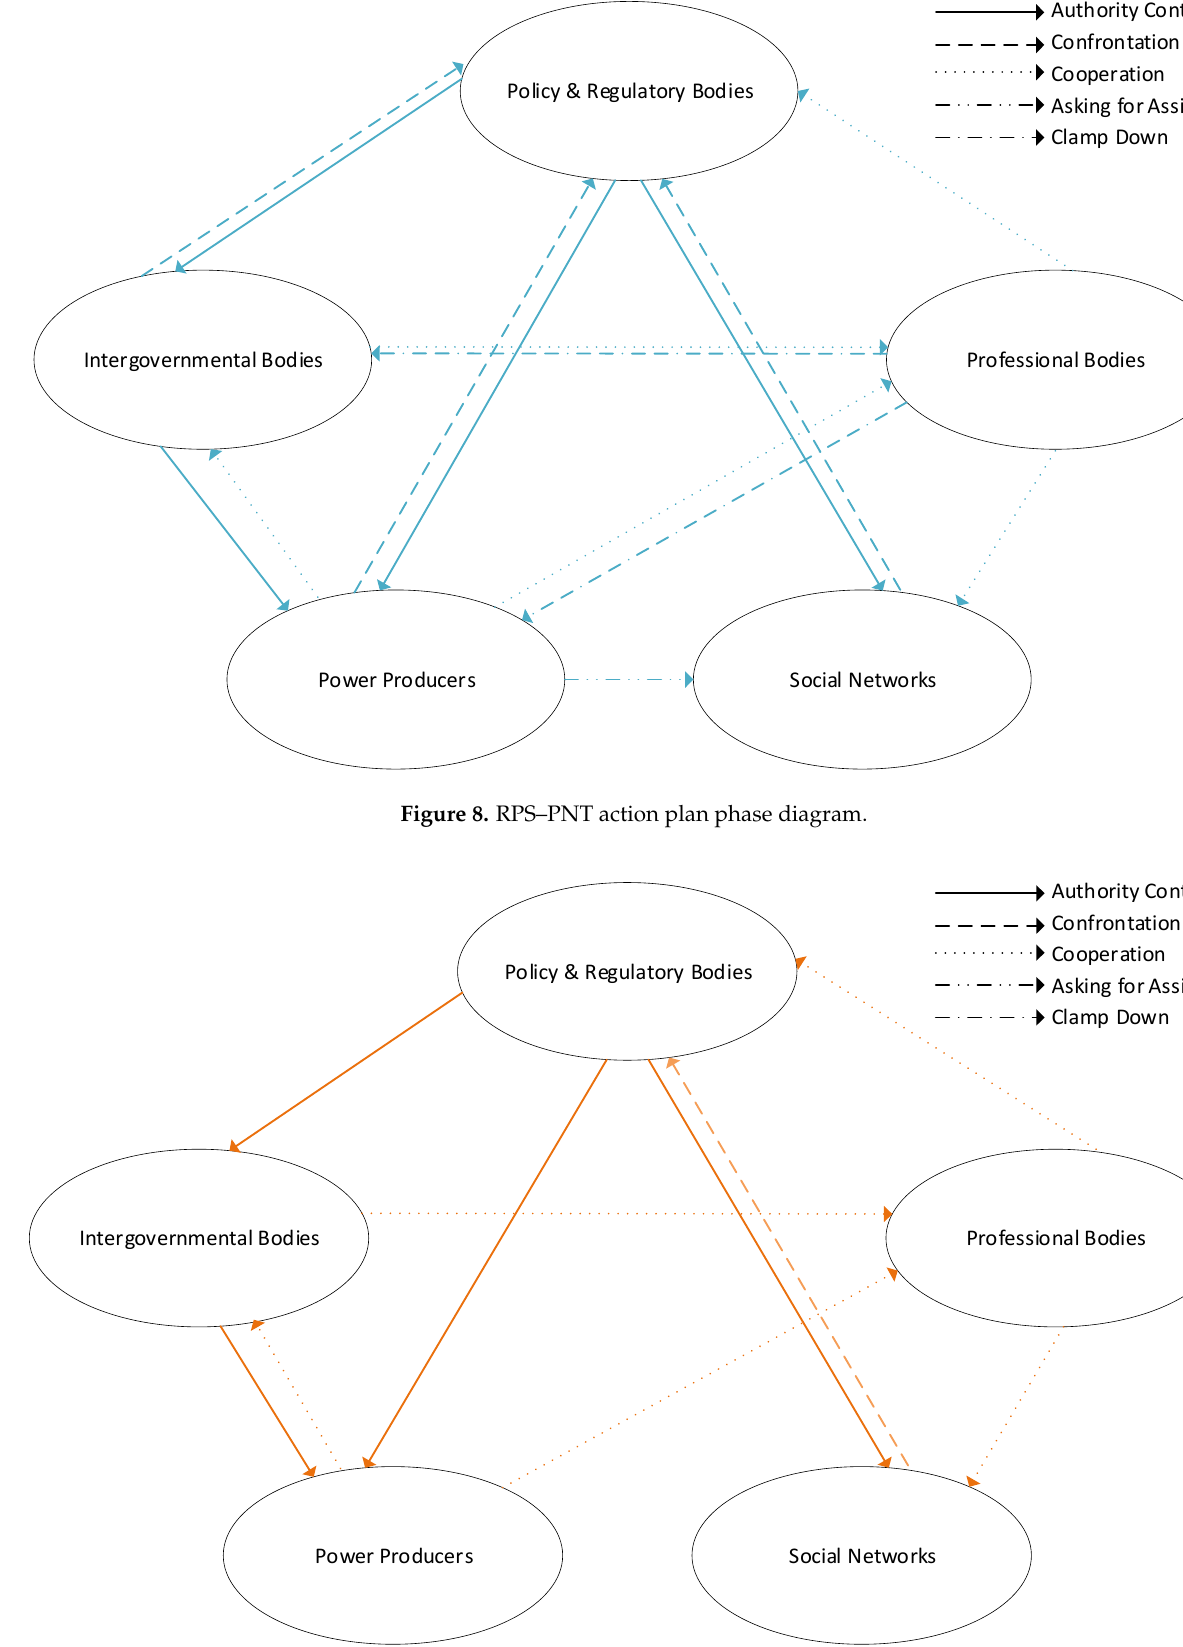
Figure 9. RPS–PNT legislative interaction phase